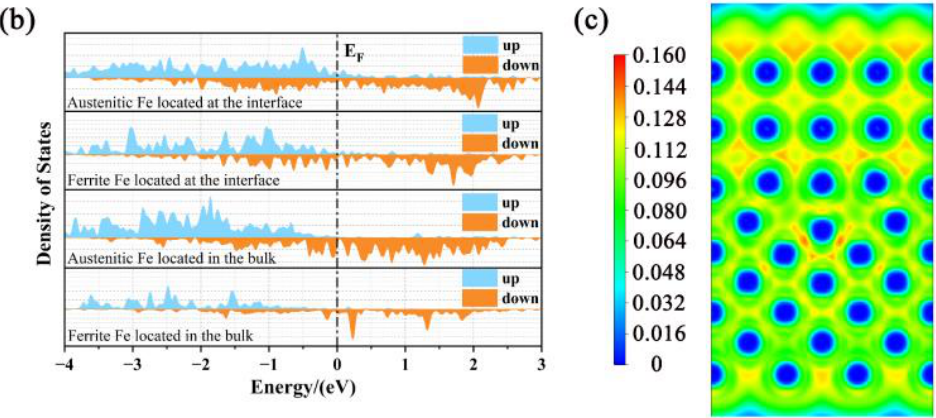
Figure 1. Model, ELF, and DOS of pure homojunction after optimization. ( a – c ) The model, DOS, and ELF, respectively. In ( b ), from top to bottom, the DOS of austenitic Fe at the interface, ferrite Fe at the interface, bulk-phase austenitic Fe, and bulk-phase ferrite Fe.